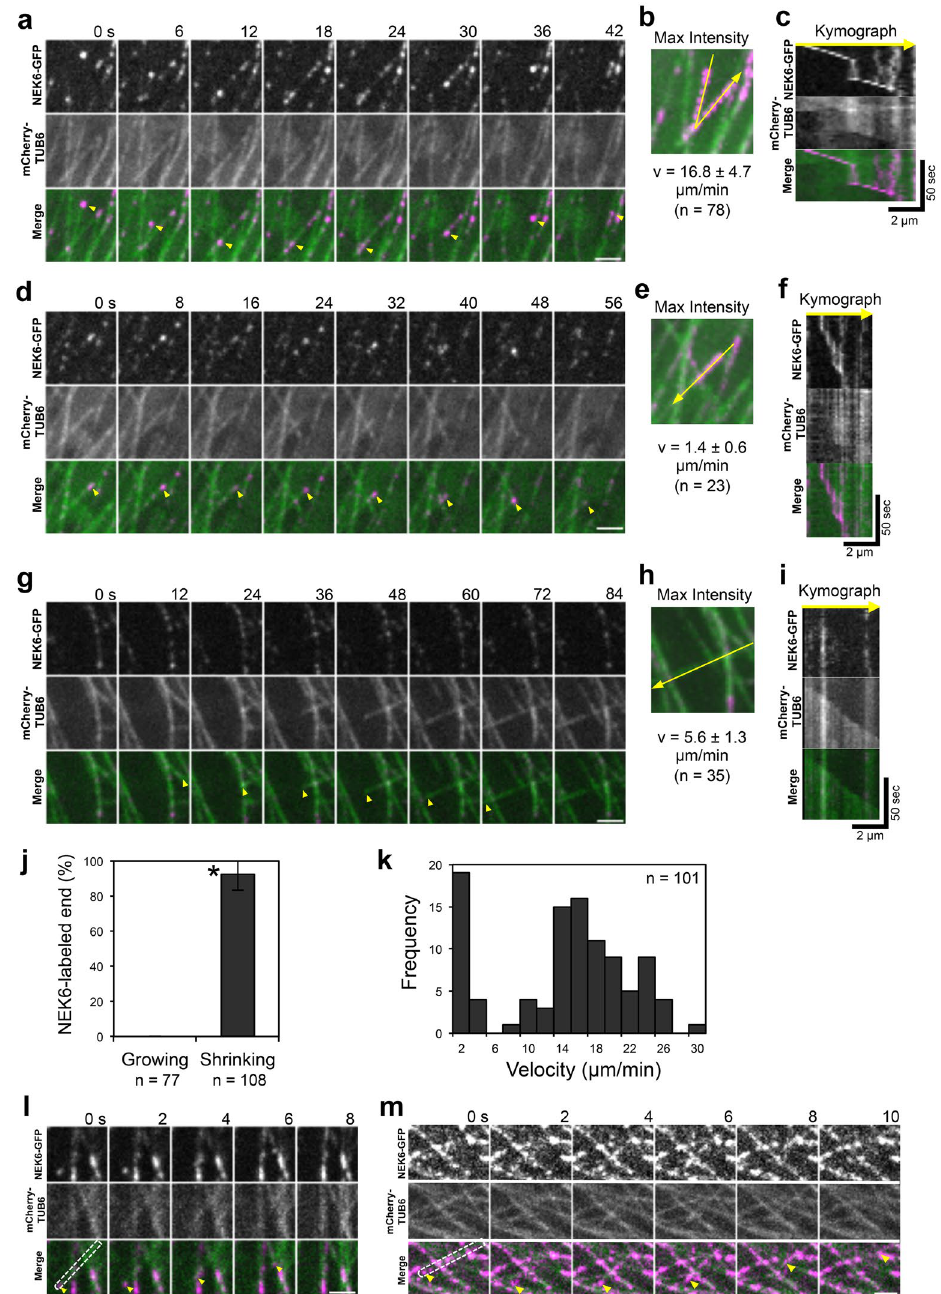
Figure 5. NEK6 Localizes to the shrinking microtubule ends. ( a ) A time-lapse montage showing that NEK6-GFP localizes to shrinking microtubule plus end. Arrowheads indicate the shrinking plus end of a microtubule. The scale bar represents 2 µ m. ( b ) A maximum intensity projection of ( a ). The yellow line shows the location of the kymograph line. ( c ) Kymograph of the line in ( b ). ( d ) A time-lapse montage showing that NEK6-GFP localizes to the shrinking microtubule minus end. Arrowheads indicate the shrinking minus end of a microtubule. The scale bar represents 2 µ m. ( e ) A maximum intensity projection of ( d ). The yellow line shows the location of the kymograph line. ( f ) Kymograph of the line in ( e ). ( g ) A time-lapse montage showing that NEK6-GFP does not localize to the growing plus end. Arrowheads indicate the growing plus end of a microtubule. The scale bar represents 2 µ m. ( h ) A maximum intensity projection of (G). The yellow line shows the location of the kymograph line. ( i ) Kymograph of the line in (H). ( j ) The percentage of growing or shrinking ends of microtubules labeled with NEK6-GFP. Data are displayed as averages ± SD. The asterisk indicates significant difference from the value in the growing ends ( t -test, P < 0.001). ( k ) Histogram of shrinking rates for NEK6-GFP-labelled microtubules. ( l , m ) A time-lapse montage showing that NEK6-GFP localizes to the shrinking end of a detached and distorted cortical microtubule. Arrowheads indicate the NEK6-GFP-localized shrinking end. The areas enclosed by broken lines indicate the detached microtubules. The scale bar represents 2 µ m. RFP signals are shown in green and GFP signals are shown in magenta in ( a – i , l , m